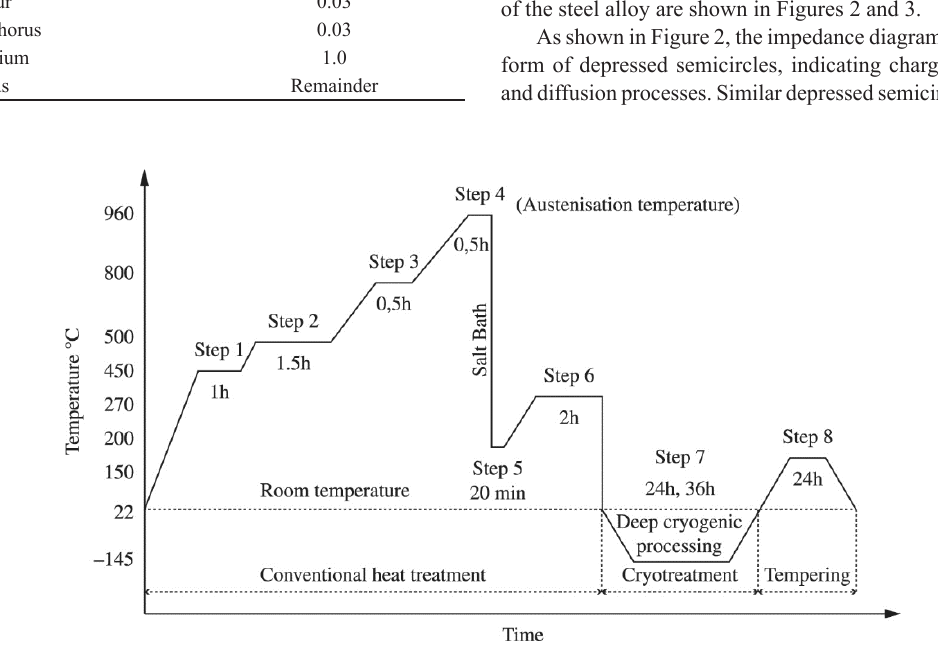
Figure 1. A schematic presentation of the heat treatment schedule consisting of the hardening, deep cryogenic treatment and tempering cycles of the samples.